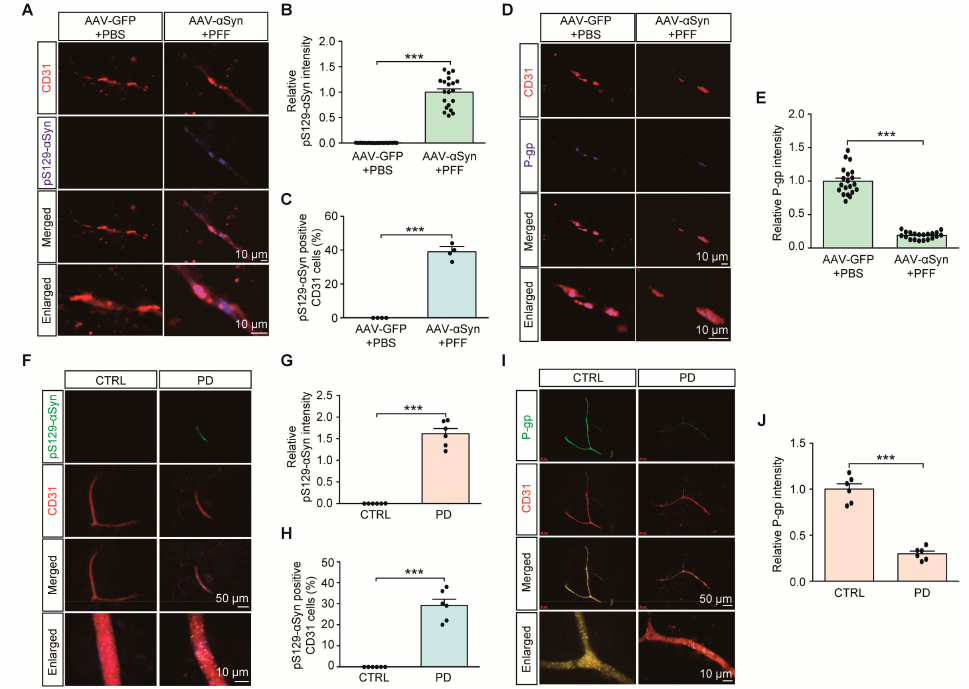
Figure 3. Endothelial α -synuclein aggregation and reduction of P-gp expression in PD. ( A ) Representative immunofluorescence of S129 phosphorylated α -synuclein (pS129- α -Syn) and CD31 in the ventral midbrain sections from mice with intranigral coinjections of AAV- α Syn (human) and α Syn preformed fibril (PFF). AAV-GFP ( AAV-Control ) and PBS were used as control injections. Scale bar = 10 µ m. ( B ) Quantification of pS129- α -Syn immunofluorescence signal intensities in CD31-positive endothelial cells from the SNpc from each mouse group ( n = 20 sections from 4 mice per group). ( C ) Percentage of CD31-positive cells with pS129- α -Syn pathologies in each mouse group ( n = 4 mice per group). ( D ) Representative immunofluorescence of P-gp and CD31 in the ventral midbrain sections from each experimental mouse group. Scale bar = 10 µ m. ( E ) Quantification of P-gp immunofluorescence signal intensities in CD31-positive endothelial cells from the SNpc from each mouse group ( n = 20 sections from 4 mice per group). ( F ) Representative immunofluorescence of S129 phosphorylated α -synuclein (pS129- α -Syn) and CD31 in the cortex sections from postmortem human brains of patients with PD and age-matched healthy controls. Scale bar = 50 or 10 µ m. ( G ) Quantification of pS129- α -Syn immunofluorescence signal intensities in CD31-positive endothelial cells from postmortem cortex sections from postmortem human brains of patients with PD and age-matched healthy controls n = 6 Con, n = 6 PD). ( H ) Percentage of CD31-positive cells with pS129- α -Syn pathologies in each group ( n = 6 Con, n = 6 PD). ( I ) Representative immunofluorescence of P-gp and CD31 in the postmortem human cortical sections from each group. Scale bar = 50 or 10 µ m. ( J ) Quantification of P-gp immunofluorescence signal intensities in CD31-positive endothelial cells from each group ( n = 6 Con, n = 6 PD). Data are expressed as mean ± SEM. *** p < 0.001, unpaired two-tailed Student’s t